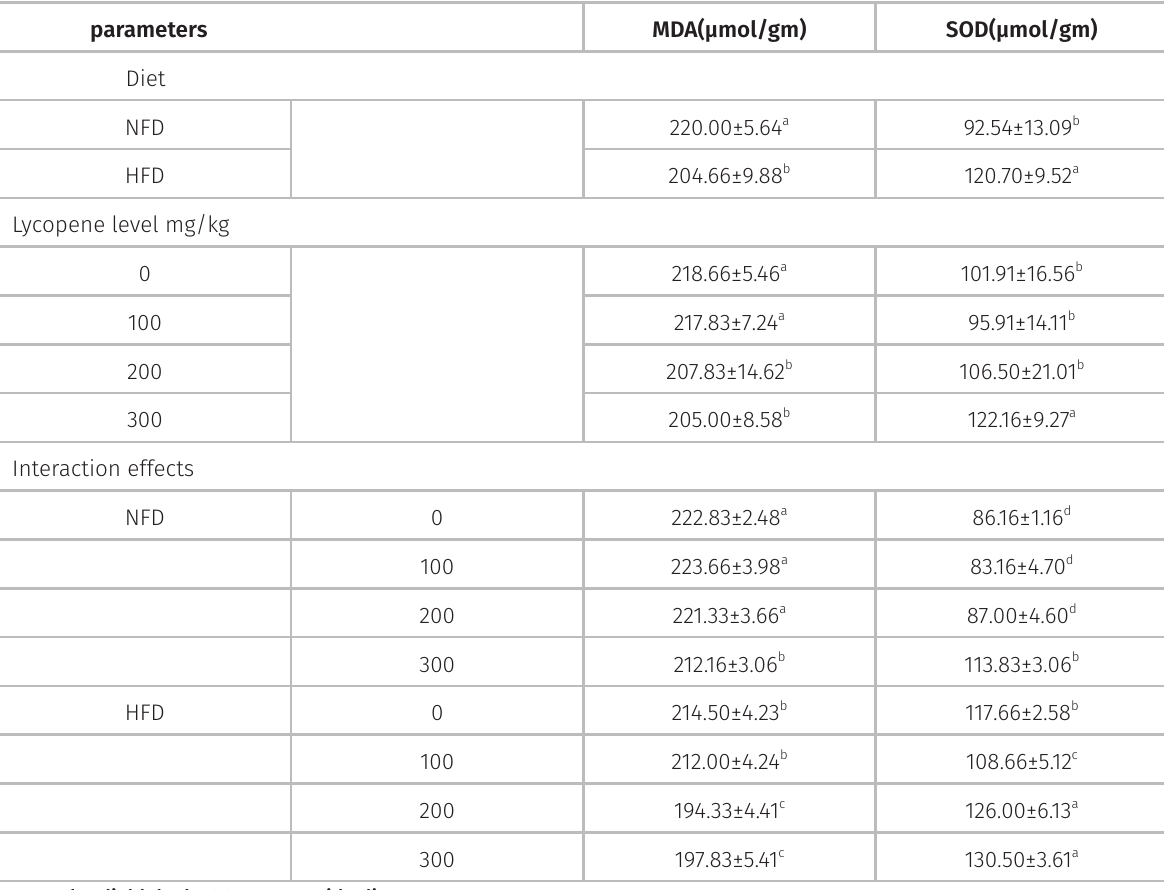
Table IV. Effects of graded levels of lycopene supplementation to normal fat diet (NFD) and high-fat diet (HFD) on antioxidant enzymes in the liver of Japanese